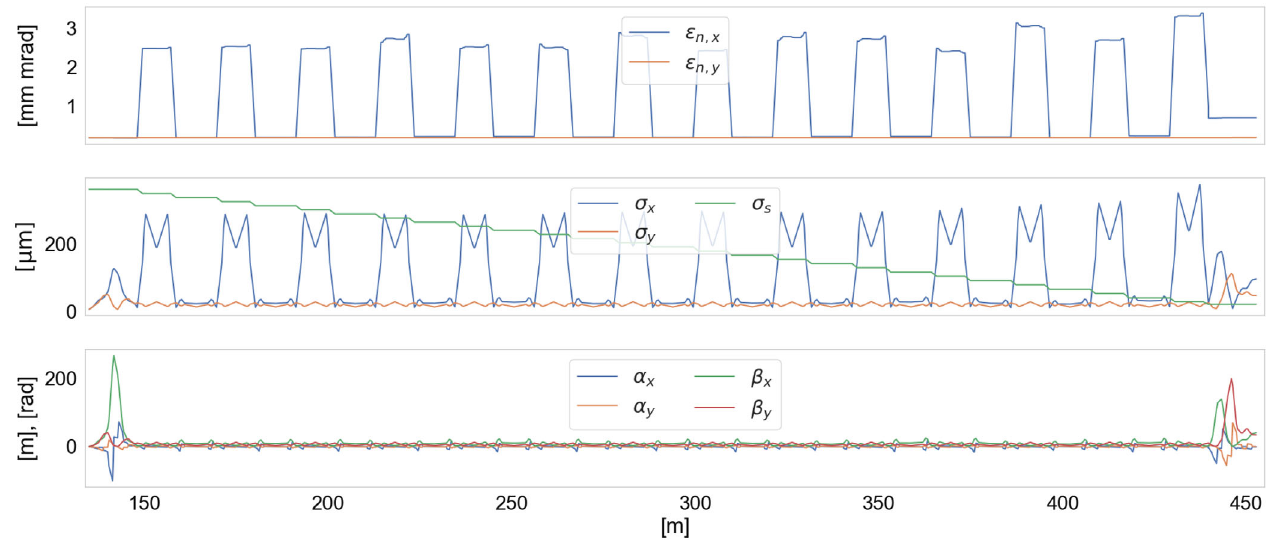
FIG. 9. Main bunch parameters in the simulation of the two passes through the matching line and the arc compressor in presence of CSR effects. Top: longitudinal and transverse beam envelopes. Middle: main Twiss parameters. Bottom: transverse normalized total beam